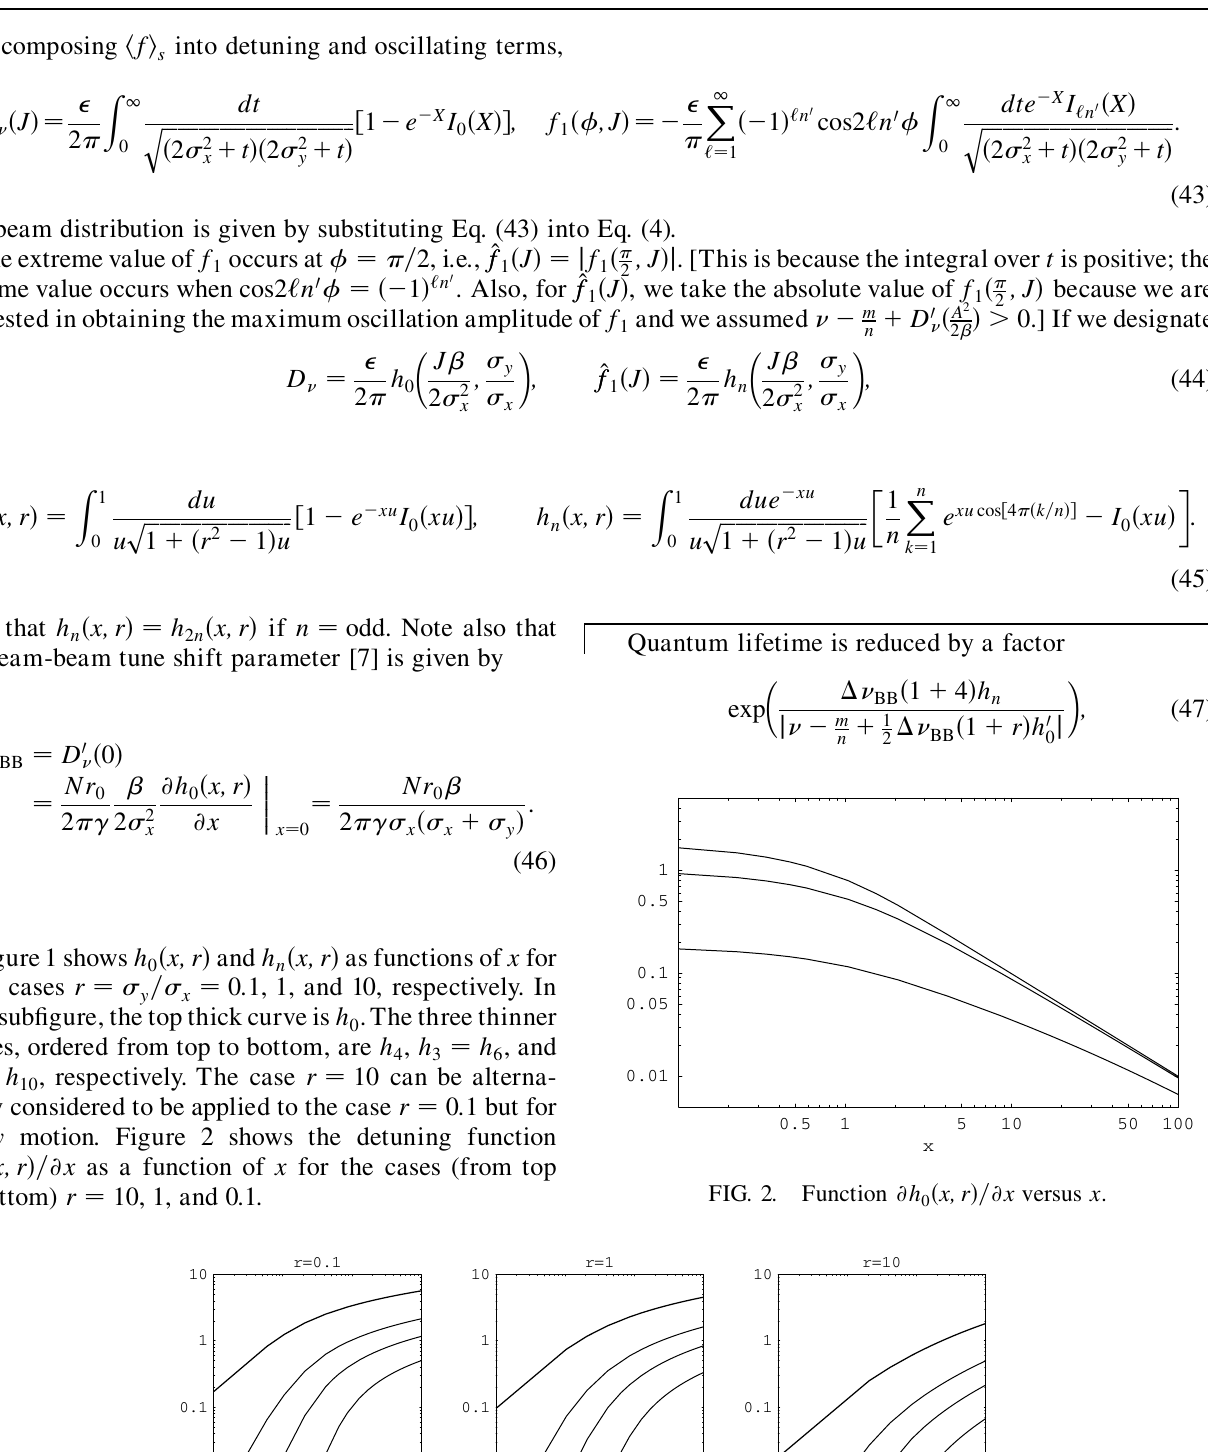
(cid:2) x; r (cid:4) and h 0